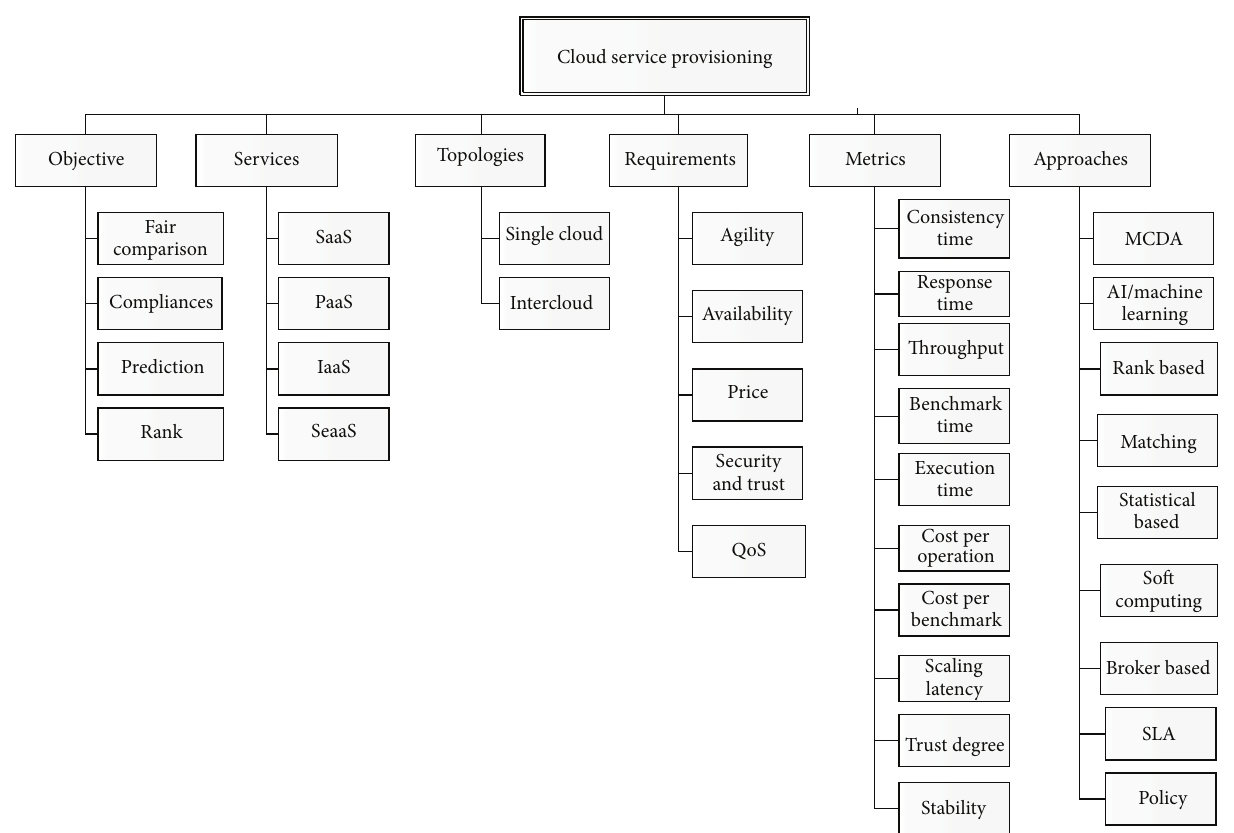
Figure 1: Taxonomy of cloud service